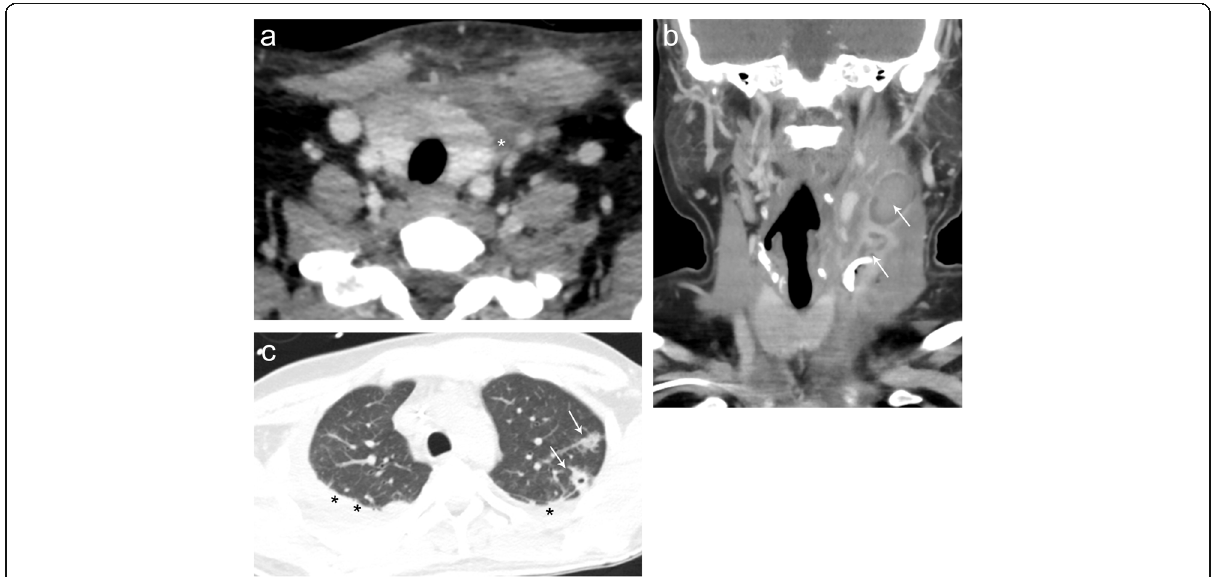
Fig. 9 Lemierre ’ s syndrome. Contrast-enhanced axial ( a ) CT image of the thoracic inlet demonstrating a filling defect (asterisk) within the left internal jugular vein consistent with acute thrombus. Contrast-enhanced coronal ( b ) CT image demonstrates the extensive inflammatory changes and abscesses (arrow) within the soft tissues of the left neck. Together, these findings are consistent with the findings of Lemierre ’ s syndrome with extension into the thoracic inlet. Axial noncontrast CT ( c ) images in a companion case demonstrating multiple septic emboli within the pulmonary parenchyma (arrows). Note that a large right and small left complex pleural fluid collection (asterisk) was also present in this